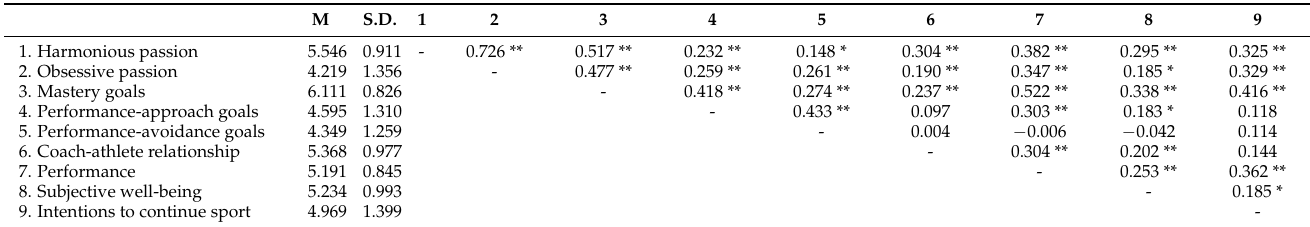
Table 1. Means, Standard Deviation, and